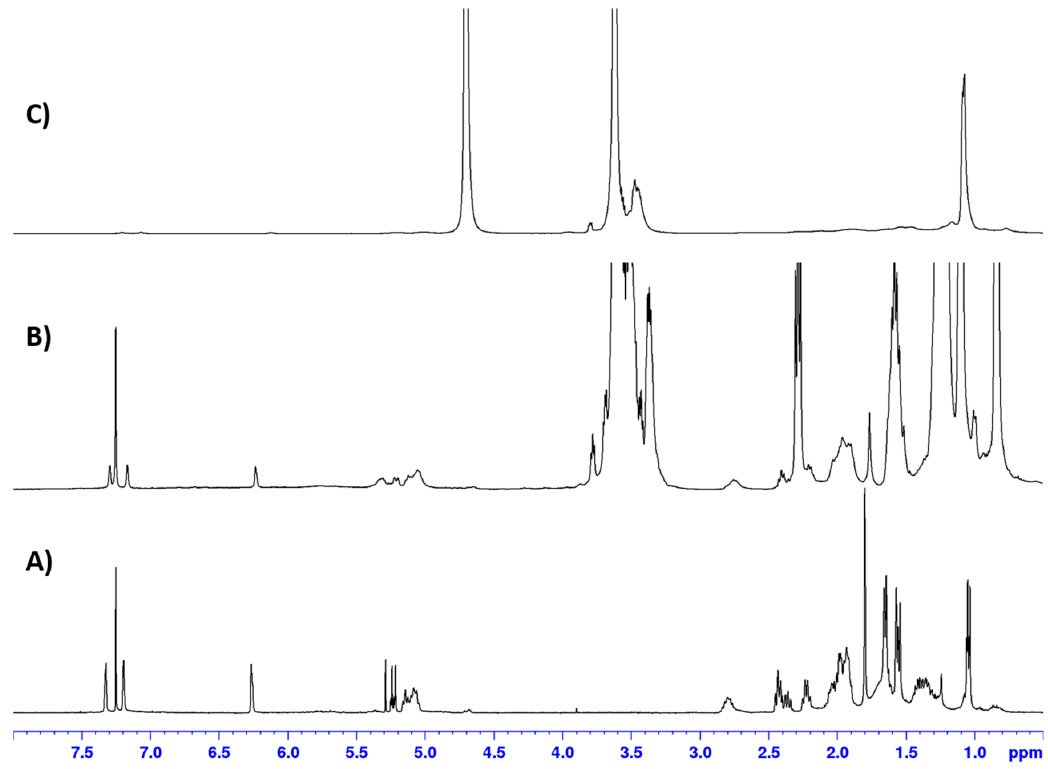
Figure 4. 1 H NMR spectra (CDCl 3 , 400 MHz) for mixture of 1 and 2 ( A ), Var-SLNs, ( B ), and the poloxamer 188 copolymer ( C ).